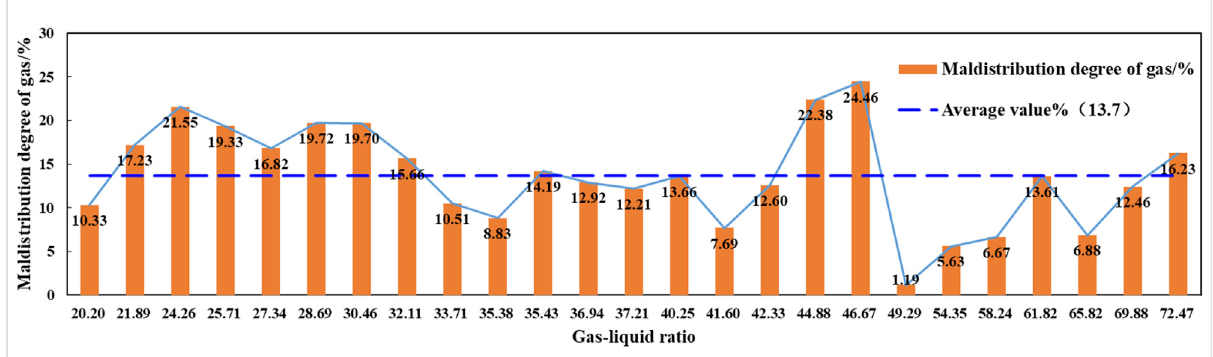
FIGURE 15 Histogram of gas – liquid ratio and maldistribution degree of gas in annular fl ow in horizontal manifold with fl ute pipes (liquid injection volume 0.16L/s+0.35L/s).